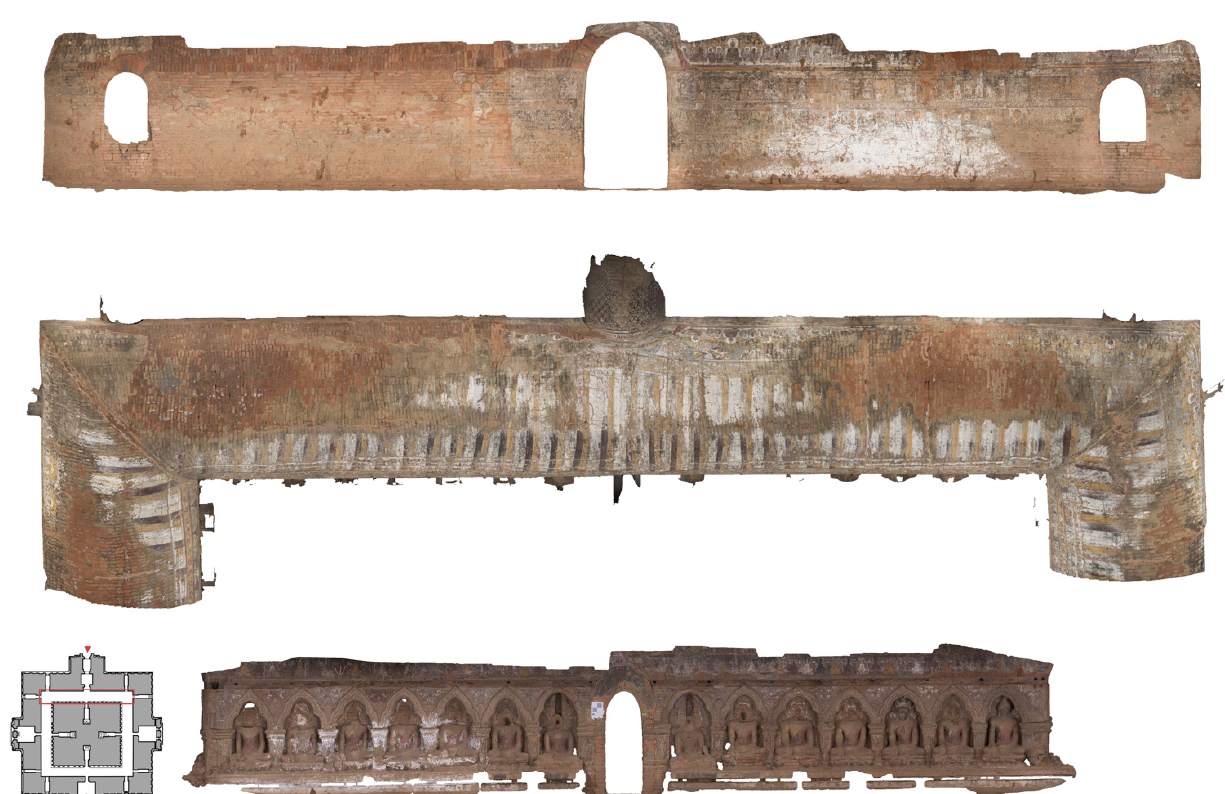
Figure 10. Orthophotos of the walls and ceiling in the west hallway of Myin-Pya-Gu made from